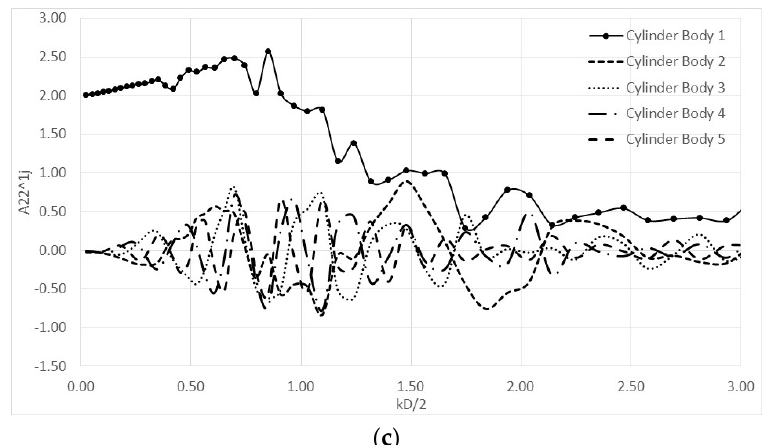
Figure 21. Dimensionless added mass of the 1st floater in the sway direction due to the forced motion in sway of the j- th floater ( j = 1, 2, …, 5) against kD/2, for the three different examined types of floaters: ( a ) conical floater; ( b ) semi-spherical floater; ( c ) cylindrical floater in the parallel array case configuration, C 1.